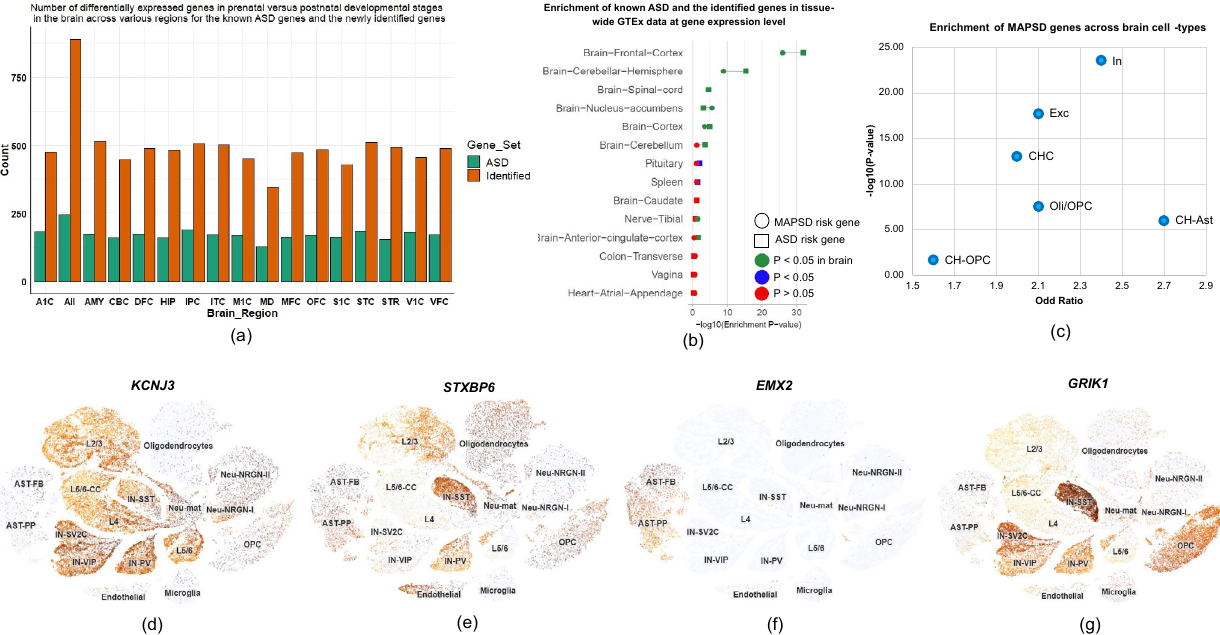
Fig. 2 Tissue-speci fi c enrichment of ASD risk genes and the new gene set identi fi ed by MAPSD. a Number of DE genes for ASD risk genes and the identi fi ed MAPSD genes across 16 brain regions in prenatal versus postnatal stages of brain development; b Enrichment of both new and known ASD risk genes at gene expression level in different tissues using GTEx data (Remaining insigni fi cant tissues are not shown); c Enrichment statistics of the MAPSD identi fi ed genes across six cell-types in the brain in scRNA-seq data from normal human brain; d – g t-SNE plots for four genes being identi fi ed by MAPSD to be DE in distinct cell-types between normal and ASD brains. Acronyms: Amygdaloid complex, posterior (caudal) superior temporal cortex (area 22c) (STC), anterior (rostral) cingulate (medial prefrontal) cortex (MFC), dorsolateral prefrontal cortex (DFC), orbital frontal cortex (OFC), inferolateral temporal cortex (area TEv, area 20) (ITC), hippocampus, ventrolateral prefrontal cortex (VFC), primary auditory cortex (A1C), primary visual cortex (V1C), striatum (STR), primary motor-sensory cortex (M1C), posteroventral (inferior) parietal cortex (IPC), primary somatosensory cortex (S1C), cerebellum (CB), and mediodorsal nucleus of thalamus, AST- FB: fi brous astrocytes, AST-PP: protoplasmic astrocytes; OPC: oligodendrocyte precursor cells, IN-PV: parvalbumin interneurons; IN-SST: somatostatin interneurons; IN-SV2C: SV2C interneurons; IN-VIP: vasoactive intestinal polypeptide interneurons; L2/3: layer 2/3 excitatory neurons; L4: layer 4 excitatory neurons; L5/6: layer 5/6 corticofugal projection neurons; L5/6-CC: layer 5/6 cortico-cortical projection neurons; Neu-mat: maturing neurons; Neu-NRGN-I: NRGN-expressing neurons; Neu-NRGN-II: NRGN-expressing (FDR = 3.4e − 14, Ratio: 3.5), SNARE interactions in vesicular transport (FDR = 0.01, Ratio: 1.6), and Glutamatergic synapse (FDR = 0.027, Ratio: 1.7). In fact, these pathways have been